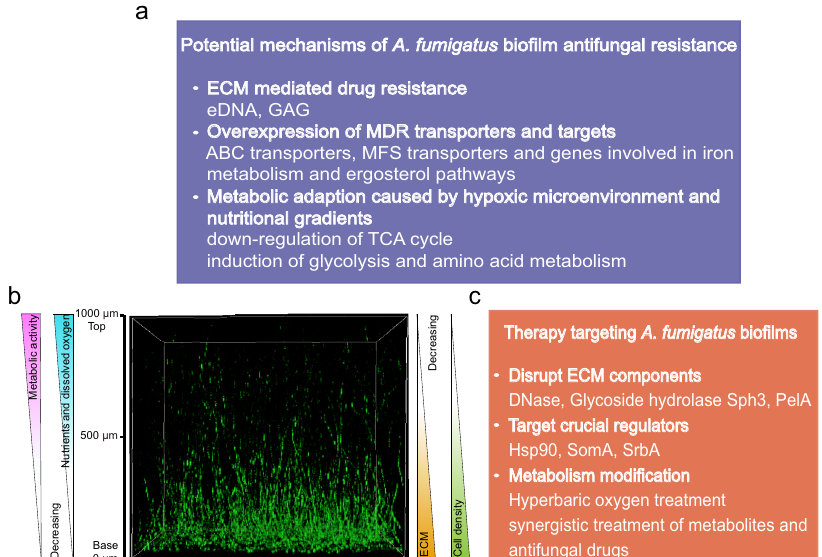
Fig. 3 Potential mechanisms of A. fumigatus bio fi lm antifungal resistance and therapeutic approaches to overcome them. a Potential antifungal resistance mechanisms within A. fumigatus bio fi lms. b 3D view of 24-hour A. fumigatus submerged bio fi lms. Gradients of oxygen, nutrients, metabolic activity, ECM, and cell density result in environmental heterogeneity within A. fumigatus bio fi lms. c Approaches to therapies targeting A. fumigatus bio fi